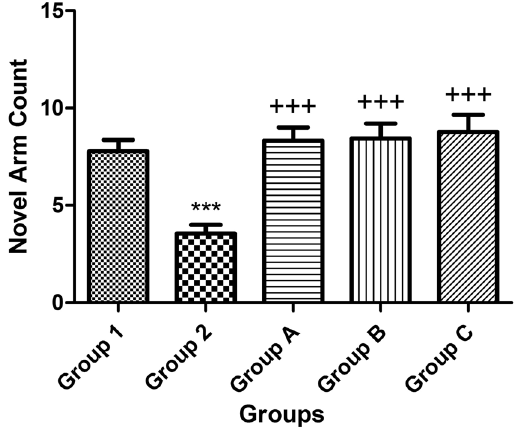
Figure 3. Effect of STZ, celecoxib, and gingerol (10 and 20 mg/kg) on the novel arm count in the intra-maze cue version of the Y-maze. Animals were divided into 5 groups. Group 1 received a single ICV dose of saline; then, after 2 weeks, animals were intraperitoneally injected with saline for seven days. Group 2 received a single injection of STZ (3 mg/kg, i.c.v.), and then, after 2 weeks, they were intraperitoneally injected with saline for 7 days. Group A was injected with STZ (3 mg/kg, i.c.v.) once, and after 2 weeks, they were injected with celecoxib (30 mg/kg, i.p.) for 7 days. Group B animals were injected with STZ (3 mg/kg, i.c.v.) once, and after 2 weeks, they were injected with gingerol (10 mg/kg/day, i.p.) for 7 days. Group C was injected with STZ (3 mg/kg, i.c.v.) once, and after 2 weeks, they were injected with gingerol (20 mg/kg/day, i.p.) for 7 days. Animals from groups A, B, and C were subjected to the behavioral tests after the 3 rd week of injections. Each result represents the mean value for 10 mice ± SE of the mean. Statistical analysis was carried out by one-way ANOVA followed by a Tukey-Kramer multiple comparison test with the aid of GraphPad Prism Software version 5. *** Significantly different from the normal group P < 0.001. +++ Significantly different from the STZ group P < 0.001.